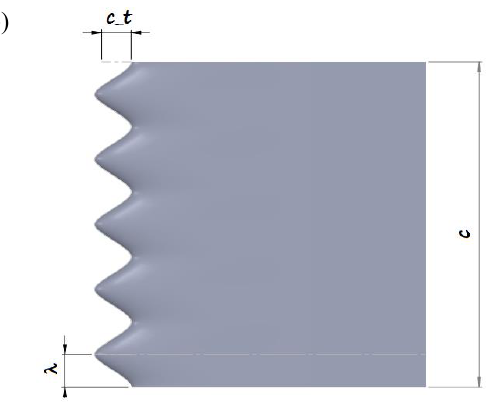
Fig. 1. The design of aerofoil.